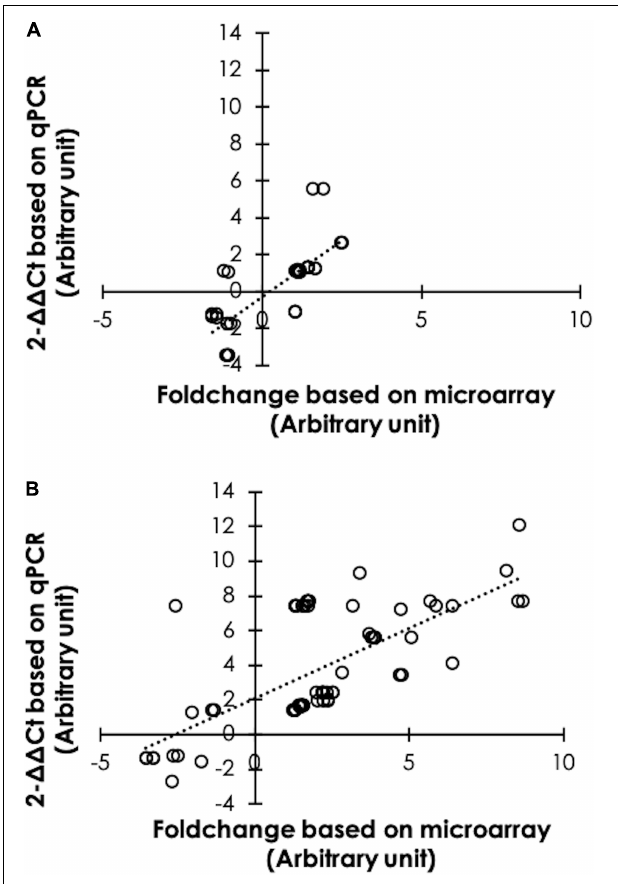
FIGURE 2 | Confirmation of differential expression. Scatter plots illustrate the comparisons between fold changes of 40 differential expressed (DE) transcripts selected from 6-week-old broilers (A) , and of 88 DE transcripts from 7-week-old broilers (B) obtained from microarray and quantitative real-time polymerase chain reaction (qPCR). The results indicated that 36 (accounted for 87.5%) and 84 (accounted for 95.5%) counterparts show comparable results between microarray and